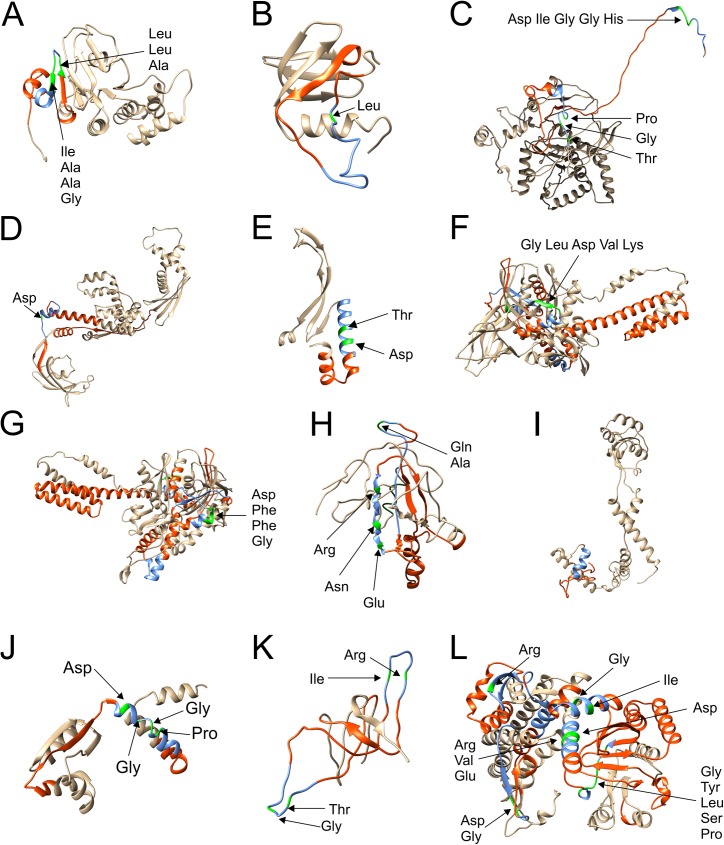
3-dimensional monomeric structure models of the immunogenic proteins.Isolated polypeptides determined in a previous work are marked in orangered, identified epitopes are highlighted in blue, amino acids crucial for antibody binding are coloured in green and individual amino acids are labeled by an arrow. A) NGO170 B) NGO0326 C) NGO0564 D) NGO0592 E) NGO0777 F) NDO1429 G) NGO1429 with a 180° turn around the y-axis and 45° turn around the x-axis. H) NGO1577 I) NGO1656 J) NGO1852 K) NGO2094 L) NGO2095.